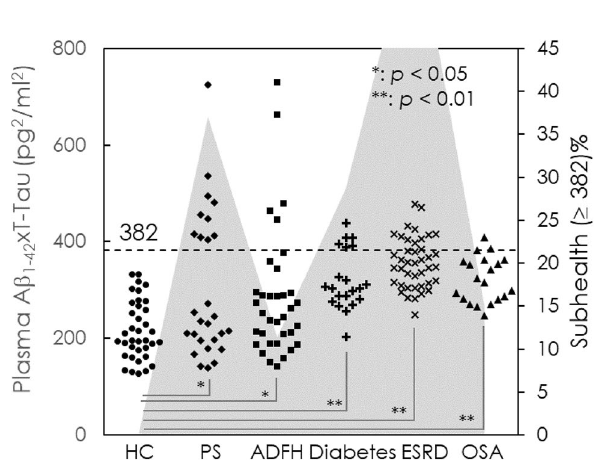
Figure 3. Dot plot of measured levels of Aβ 1–42 xT-Tau in the plasma of healthy controls (HCs), poststroke subjects (PS), individuals with a family history of Alzheimer’s disease (ADFH), and patients with end-stage renal disease (ESRD), obstructive sleep apnea (OSA) and Alzheimer’s disease (AD). The prevalence of subhealth (Aβ 1–42 xT-Tau ≥ 382) in each group is plotted with a gray